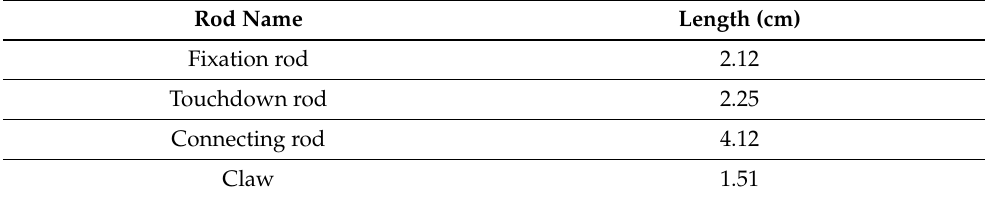
Table 1. The length of each